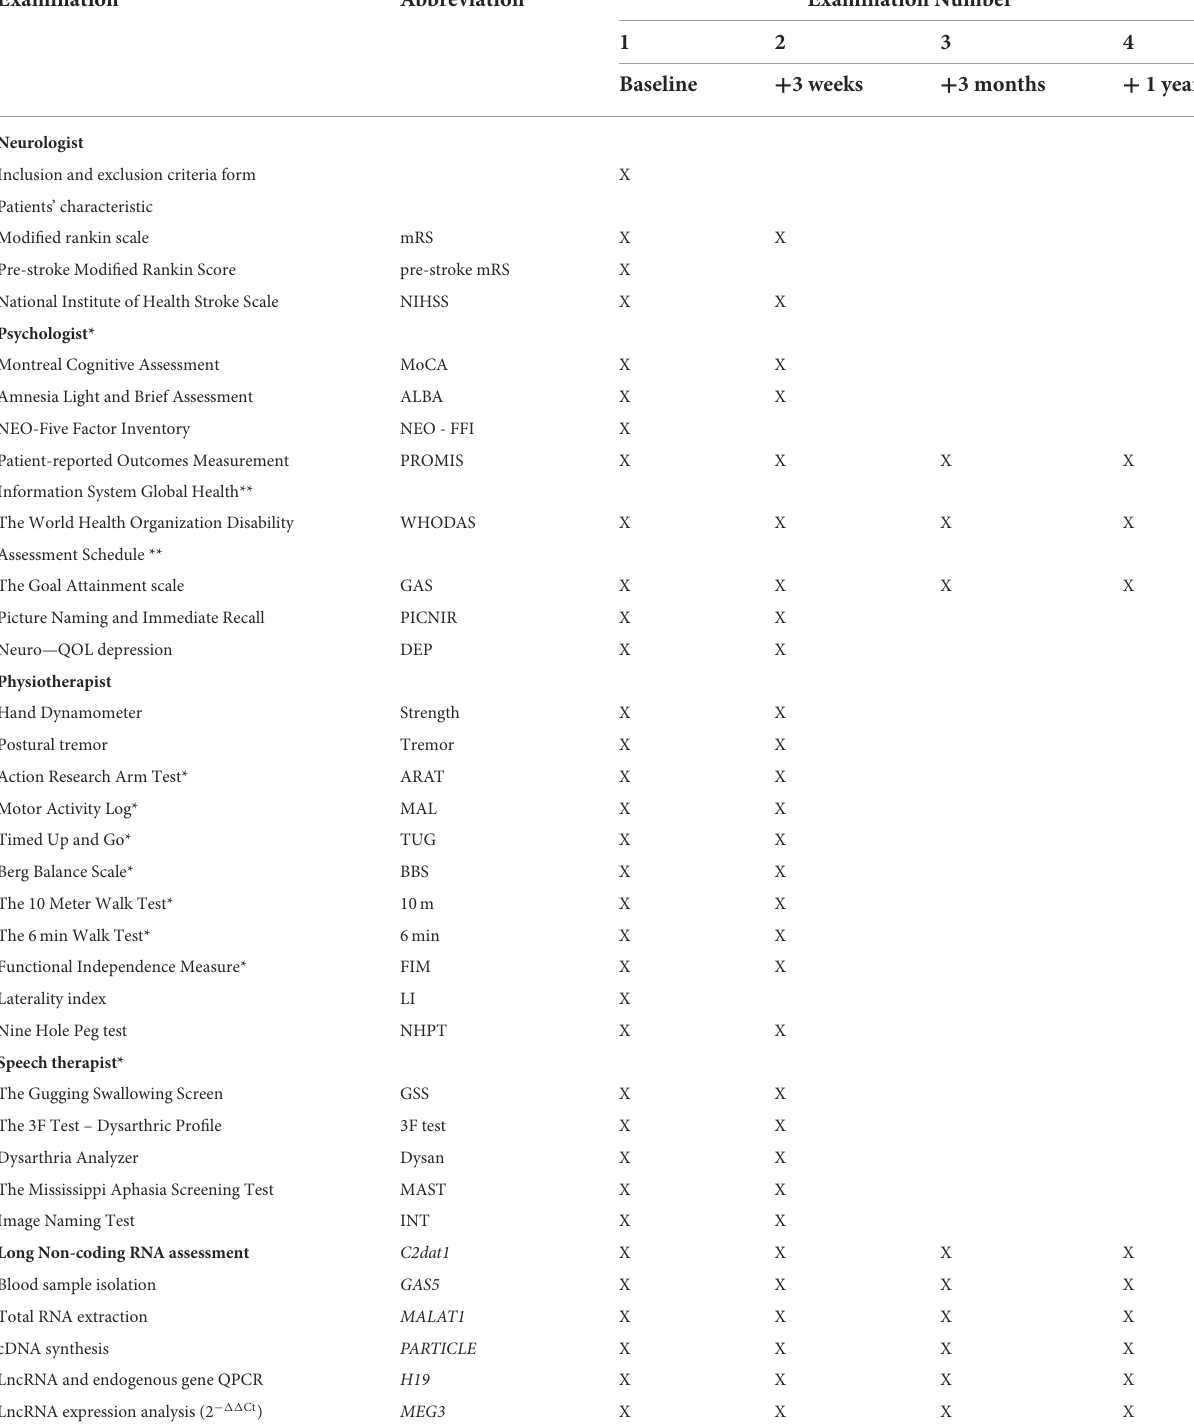
TABLE 5 Examination timing and distribution by the